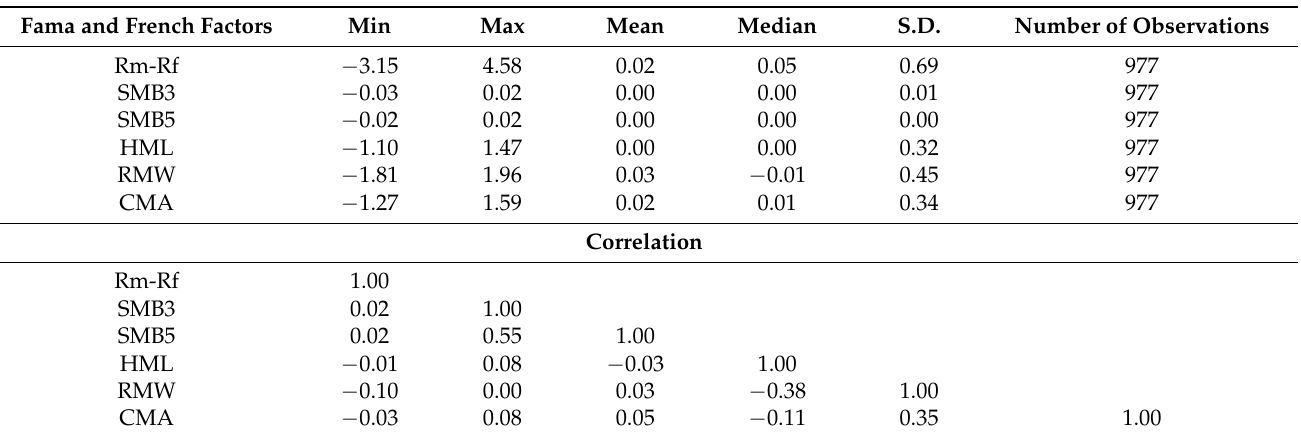
Table 2. Data description for Fama and French